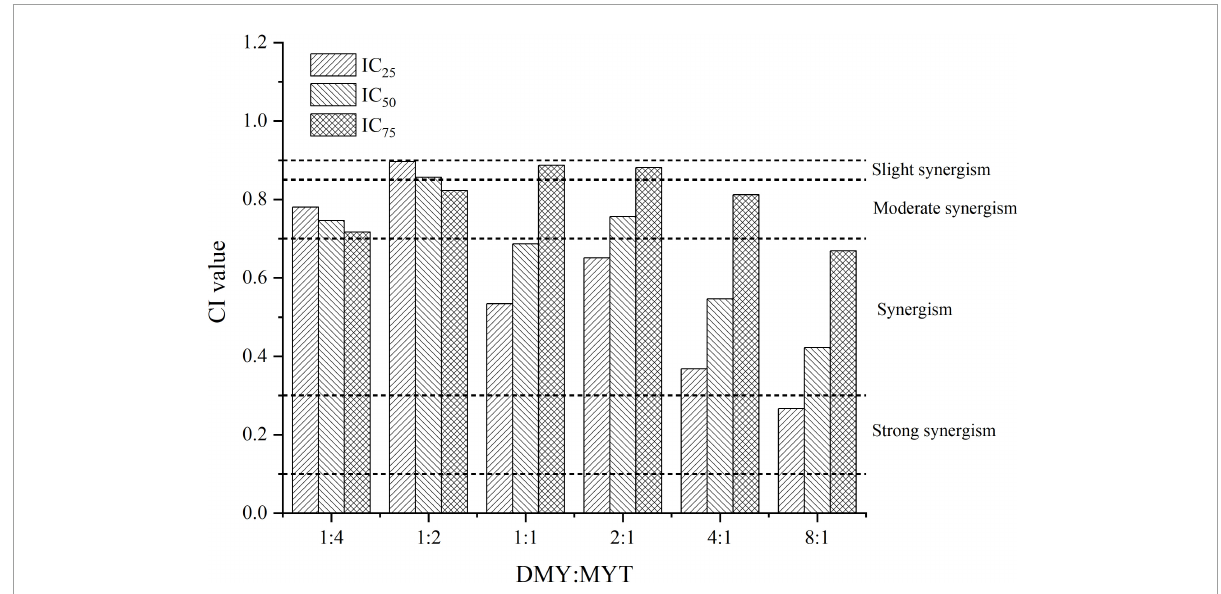
FIGURE5 Analysis of the combined inhibitory effects of DMY and MYT on B16F10 cell proliferation. Values are means ± SD ( n = 3). B16F10 cells were treated with DMY, MYT, or mix-use (1:4 ∼ 8:1) for 72 h, before assessment of viability by MTT assay. The CI value was calculated by the equation. DMY, dihydromyricetin; MYT, myricitrin.